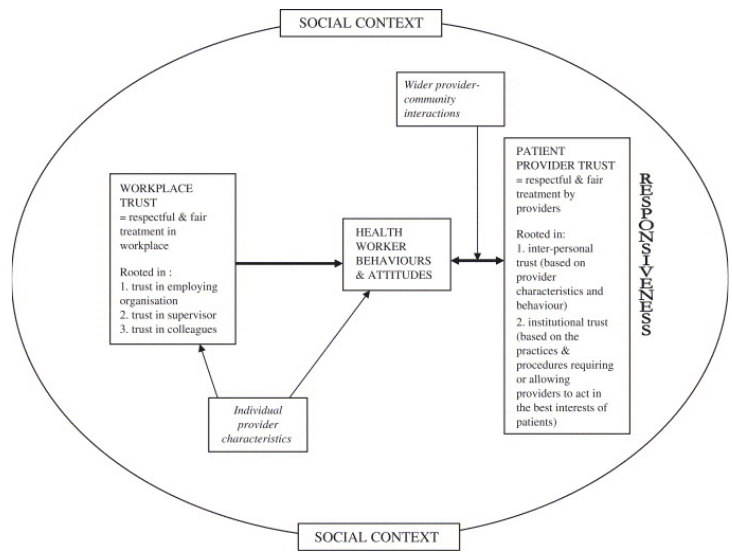
Figure 1. Conceptual framework on trust from Gilson et al. [27] .